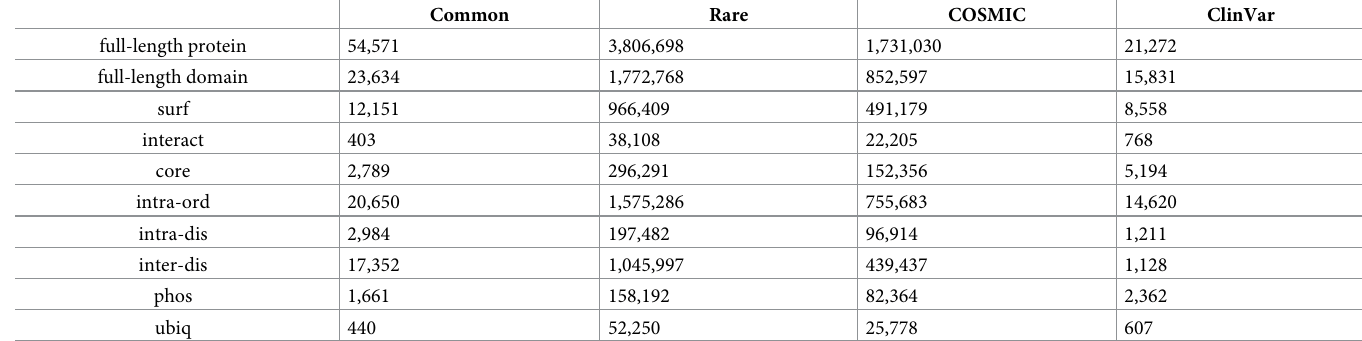
Table 1. Numbers of missense variants which localise to different levels and regions of protein anatomy. Data are listed for each of gnomAD, COSMIC, and ClinVar datasets. Here, “common” and “rare” variants are subset of gnomAD defined using the minor allele frequency (MAF) cutoff of 0.01, below which variants are classified as “rare.” This definition is used throughout this work except for the analysis on varying the “rarity” of variants (see main text). Note that the full-length domain-type statistics are omitted here, as by definition they will be identical to the “full-length domain” row. Fig 1B illustrates the definition of regions listed here in the first